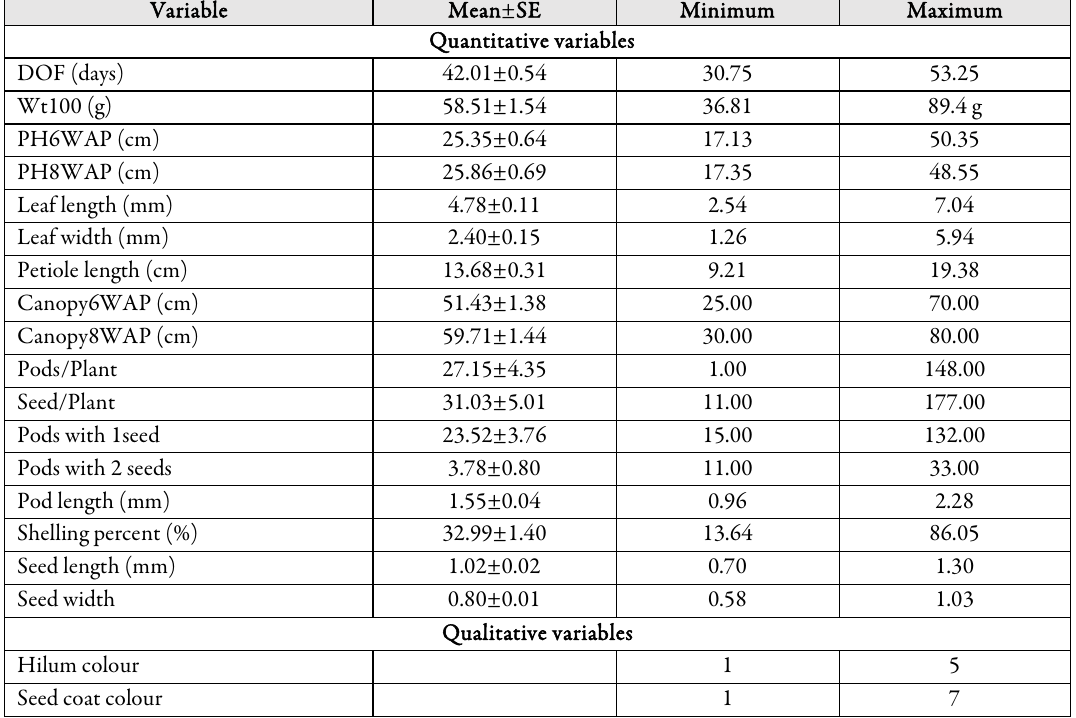
Table 2. Descriptive statistics of the nineteen descriptors employed for diversity analysis of the